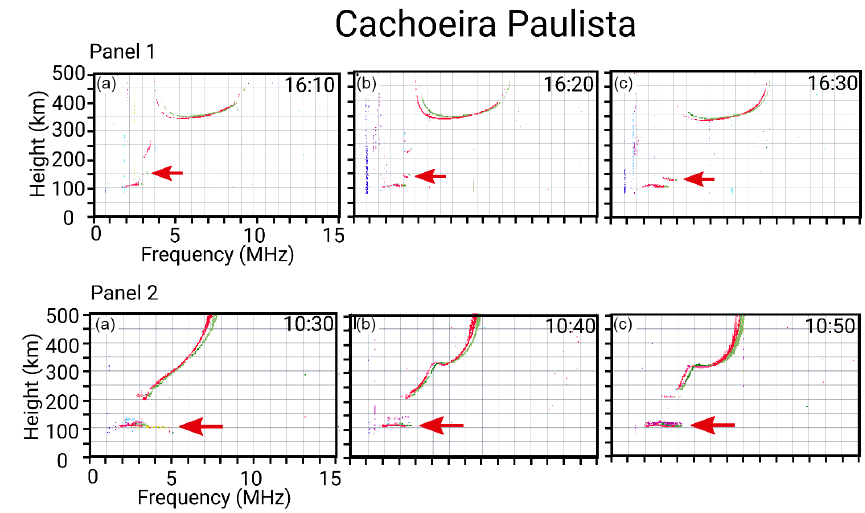
Figure 5. Sequence of ionograms where it is possible to identify the different types of Es: “h” (panel 1) and “l” (panel 2).